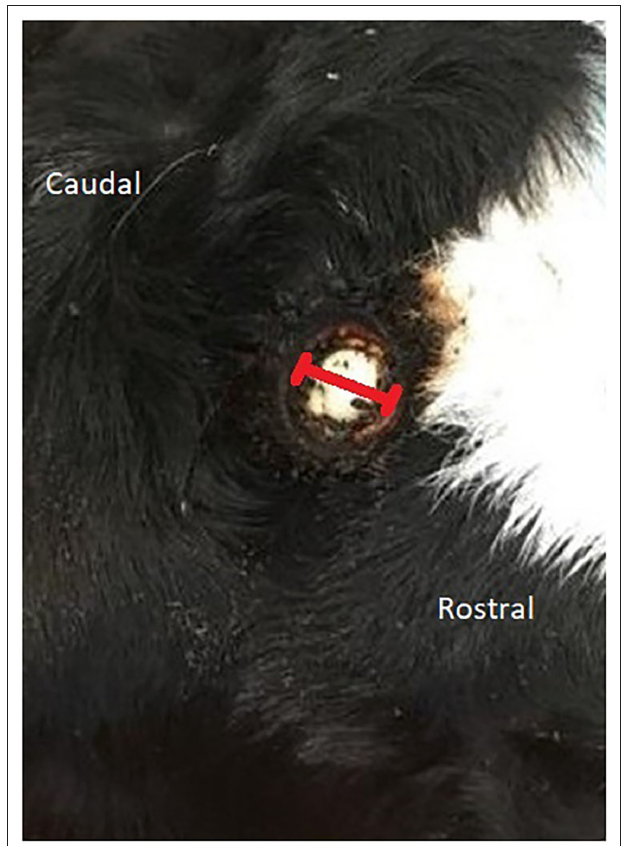
FIGURE 1 | The direction of the measurement of the wound post disbudding.